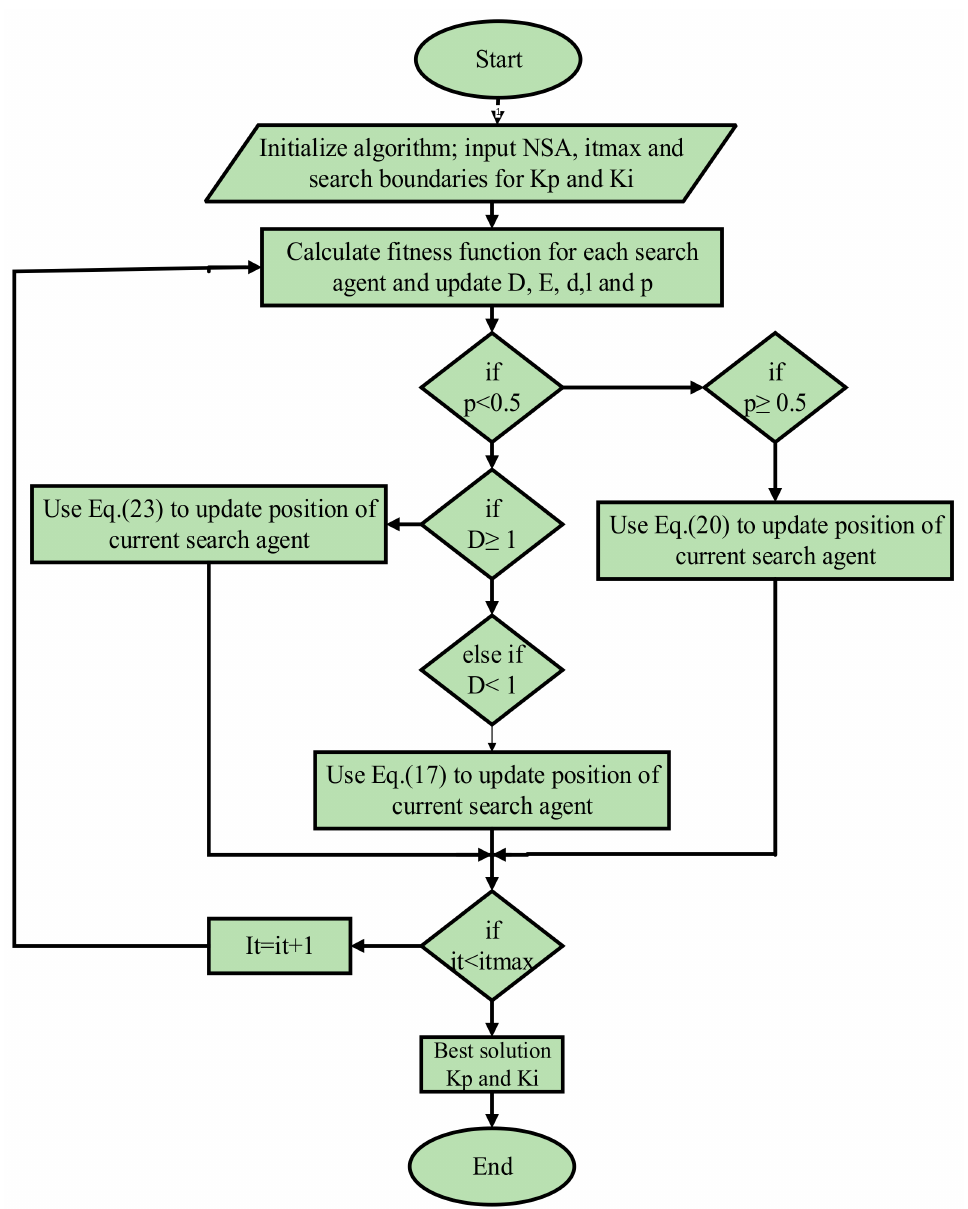
Figure 5. Flowchart of proposed WOA for finding optimal values of PI